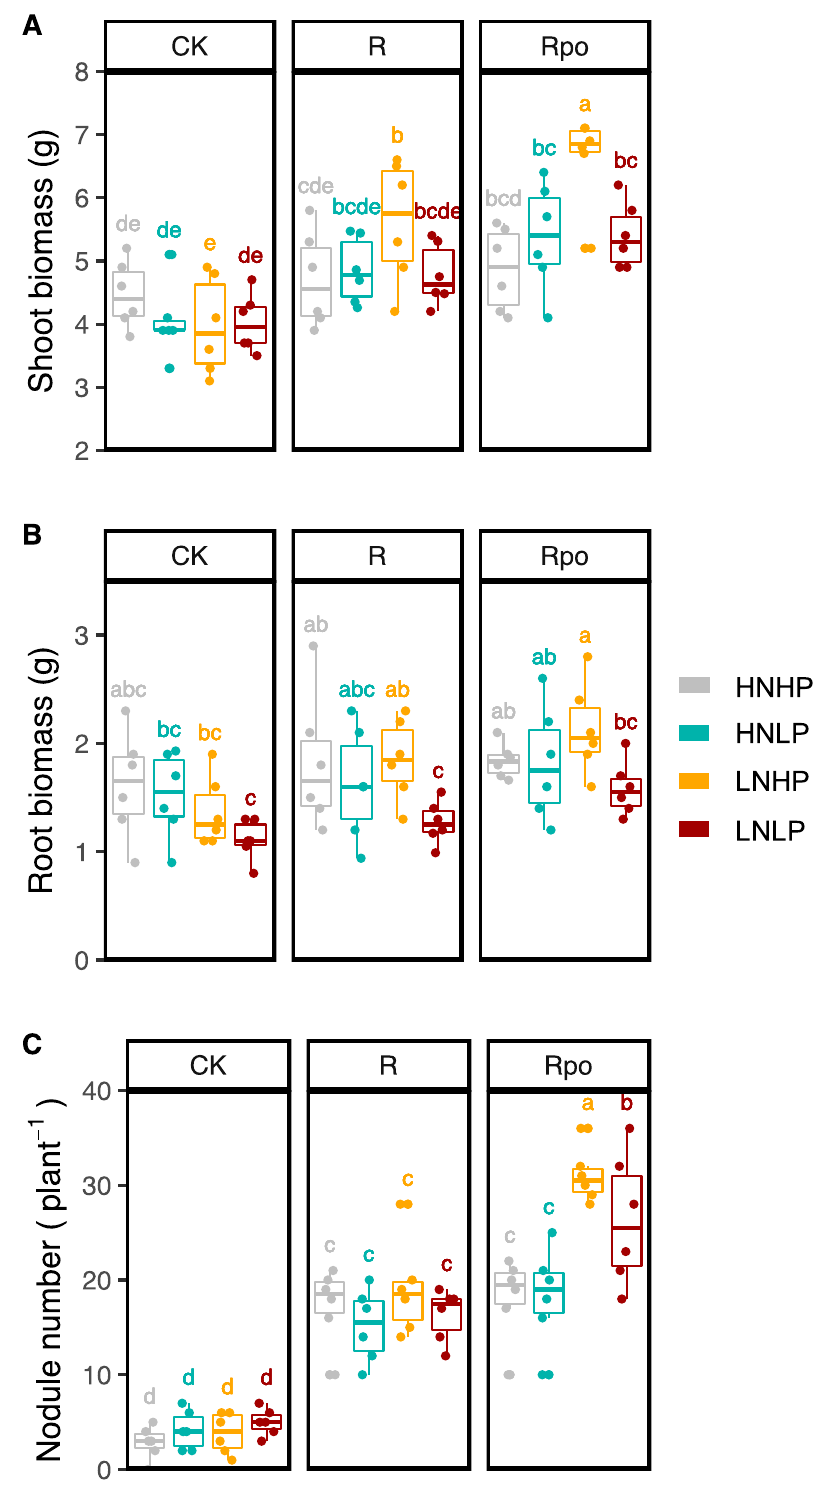
Figure 2. Shoot biomass ( A ), root biomass ( B ), and nodule number ( C ) of soybean plants after exclusive Rhizobium inoculation and Rhizobium inoculation combined with biochar application under high or low N and P supply. Letters within each column are significantly different at p < 0.05 based on Duncan’s test. HNHP, high N and high P; HNLP, high N and low P; LNHP, low N and high P; LNLP, low N and low P; CK, control; R, rhizobium inoculation; Rpo, rhizobium inoculation with biochar application.